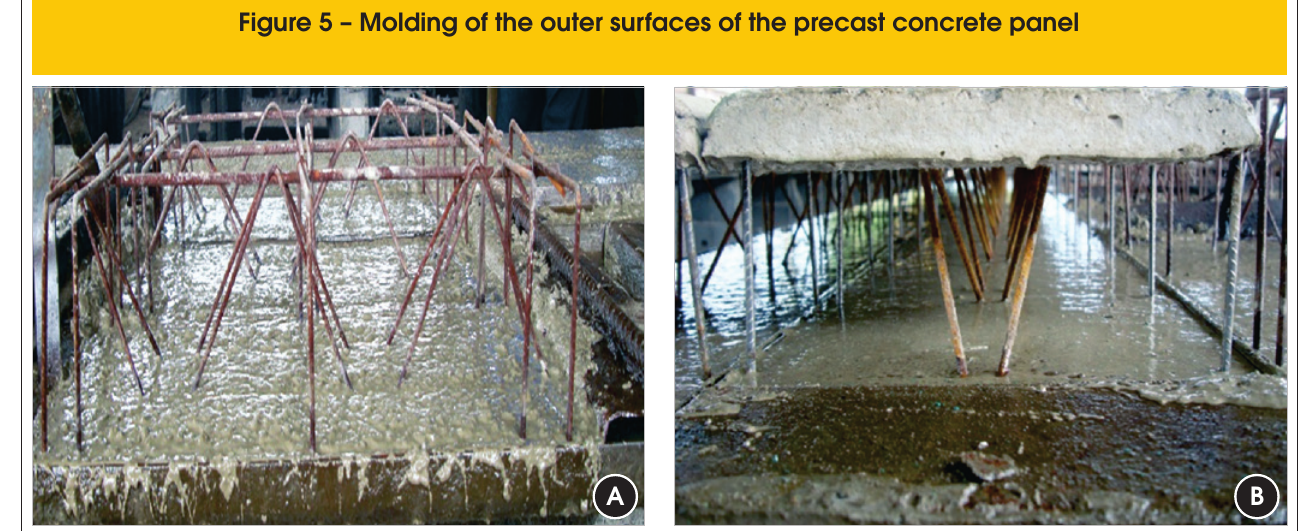
A B Concreting of the opposite